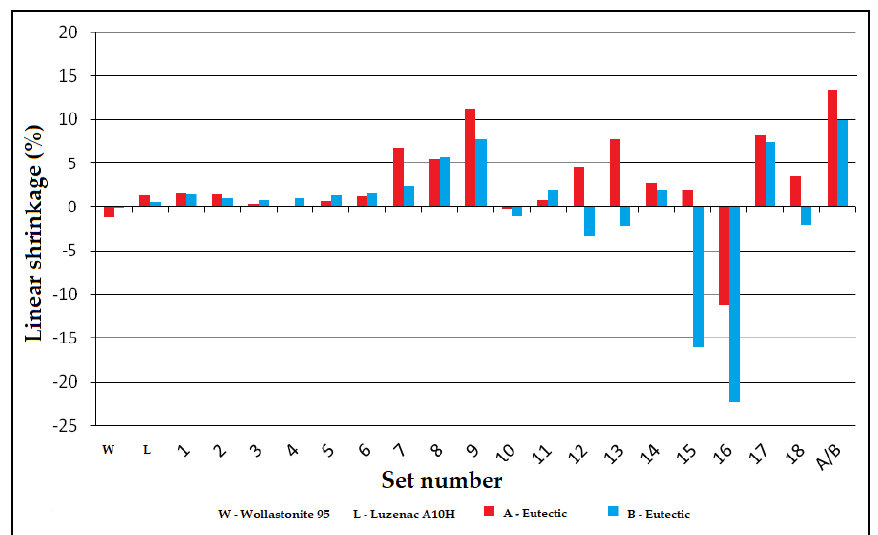
Figure 9. Comparison of the linear shrinkage of the A/B eutectic–wollastonite–talc.